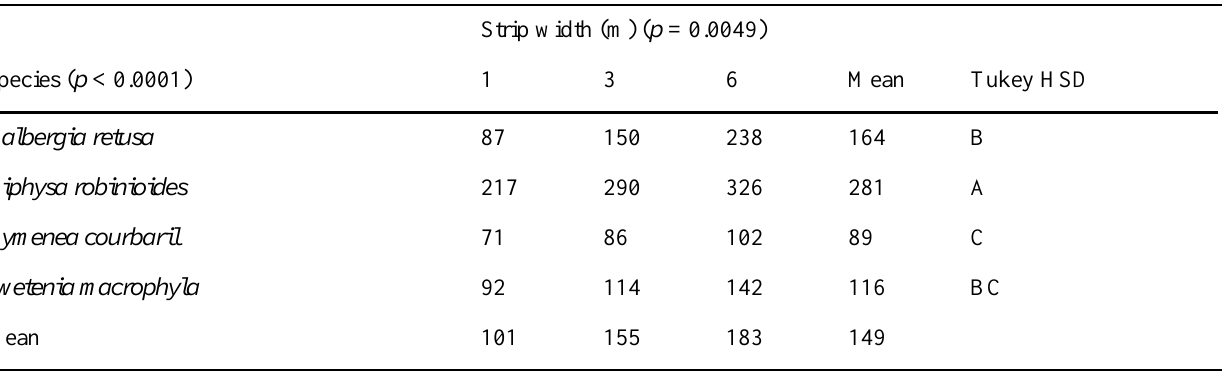
Table 2. Third-year height of surviving trees (cm) (September 2005–February 2008) from the Ipetí plantation and ANOVA